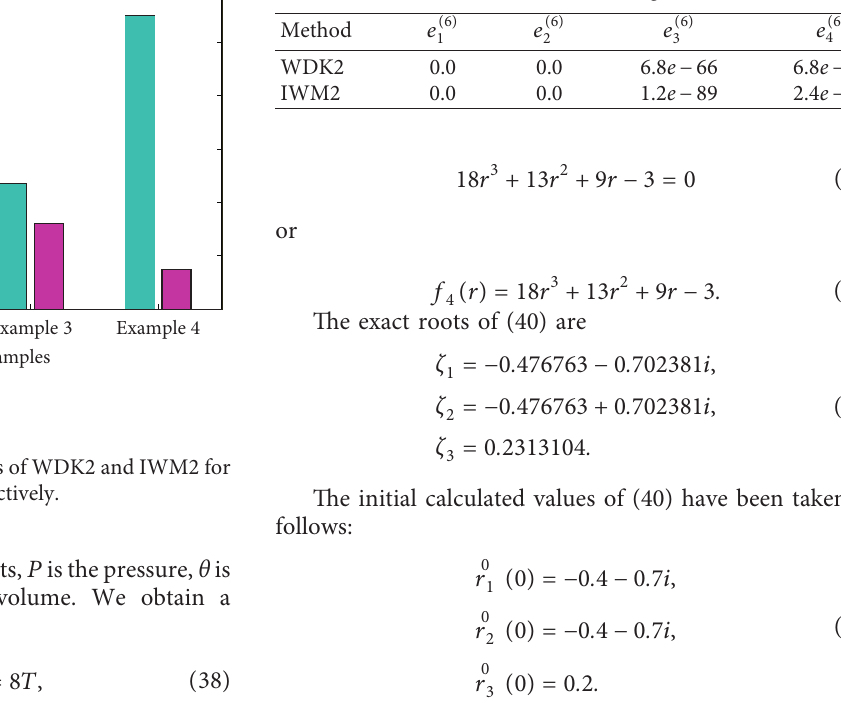
( r ) � sin (( r − 1 ) /2 ) cos (( r − 3 ) /2 ) + 1 of the iterative 2 Table 2: Simultaneous finding of all